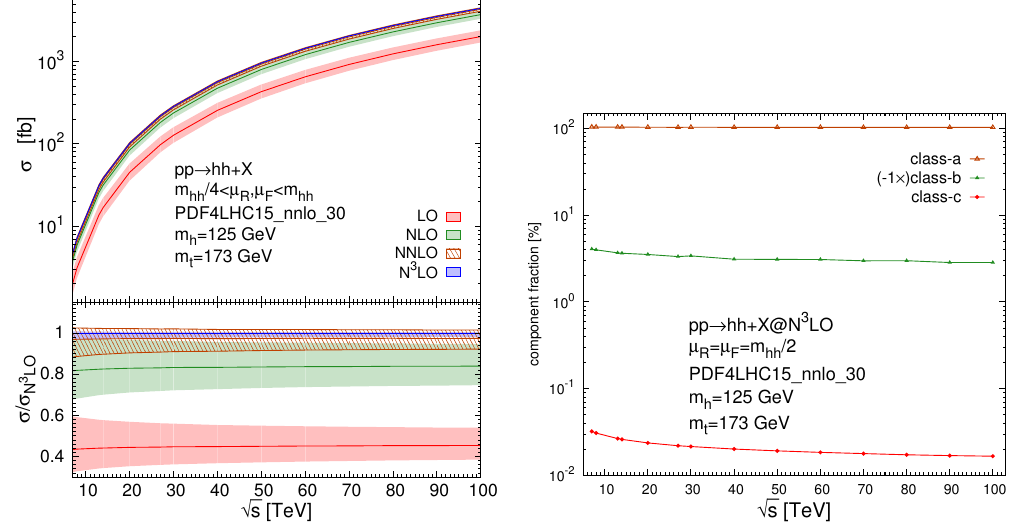
Figure 9 . The inclusive total cross sections (left) and the contribution breakdown of three classes (right) for the Higgs boson pair production in proton-proton collisions as a function of bands represent the scale uncertainties.